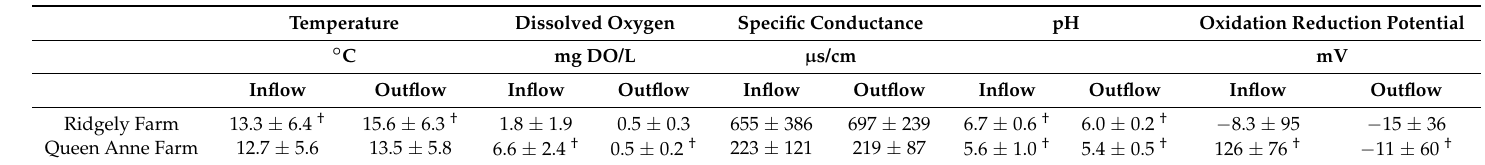
Table 4. Water chemistry mean ± SD for Ridgely ( n = 67 samples) and Queen Anne bioreactor ( n = 50 samples) inflow and outflow. Temperature Dissolved Oxygen Specific Conductance pH Oxidation Reduction Potential ◦